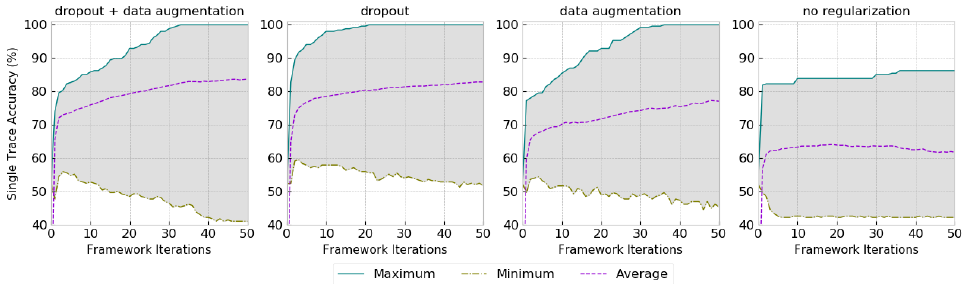
Figure 9: Random CNN hyperparameters: minimum, maximum, and average single trace accuracy with iterative framework on the cswap-arith dataset.